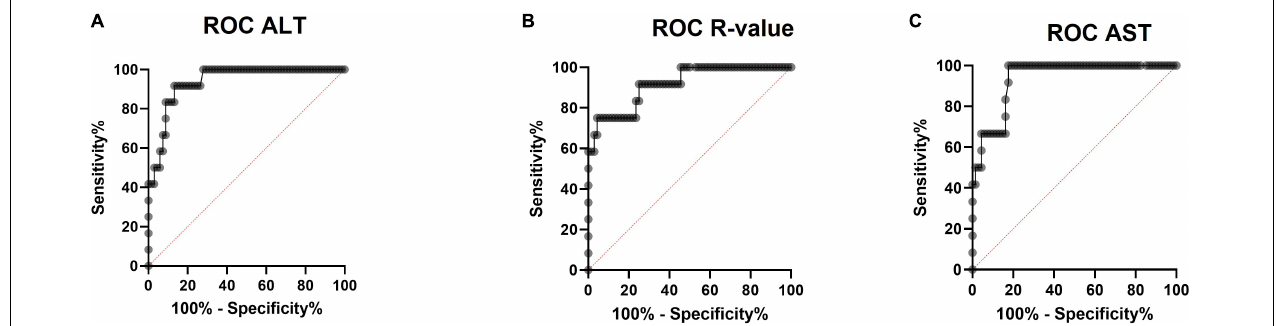
FIGURE 3 | Determination of liver function parameters as a guide for HEV testing using receiver operating characteristic (ROC) curve. The ROC was plotted to identify the plasma ALT (A) , R-value (B) , and AST (C) threshold that differentiates between HEV suspected drug-induced liver injury (DILI) and non-HEV suspected DILI. (A) ROC curve for ALT showing the ALT threshold that differentiates between HEV and non-HEV cases. (B) ROC curve for R -value showing the R -value threshold that differentiates between HEV and non-HEV cases. (C) ROC curve for AST showing the AST threshold that differentiates between HEV and non-HEV